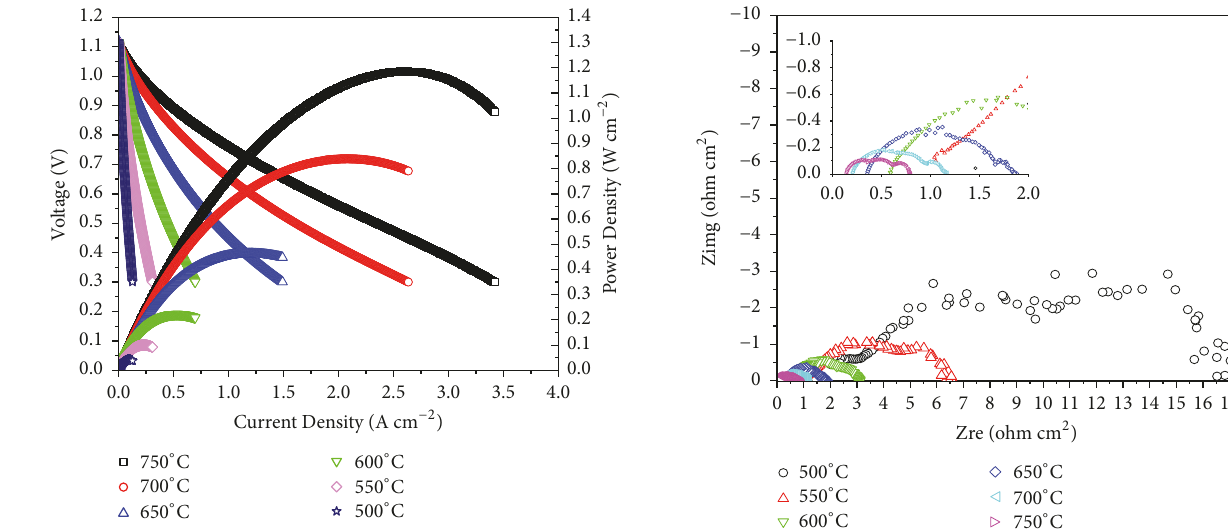
Figure 7: Impedance curves at different temperatures.